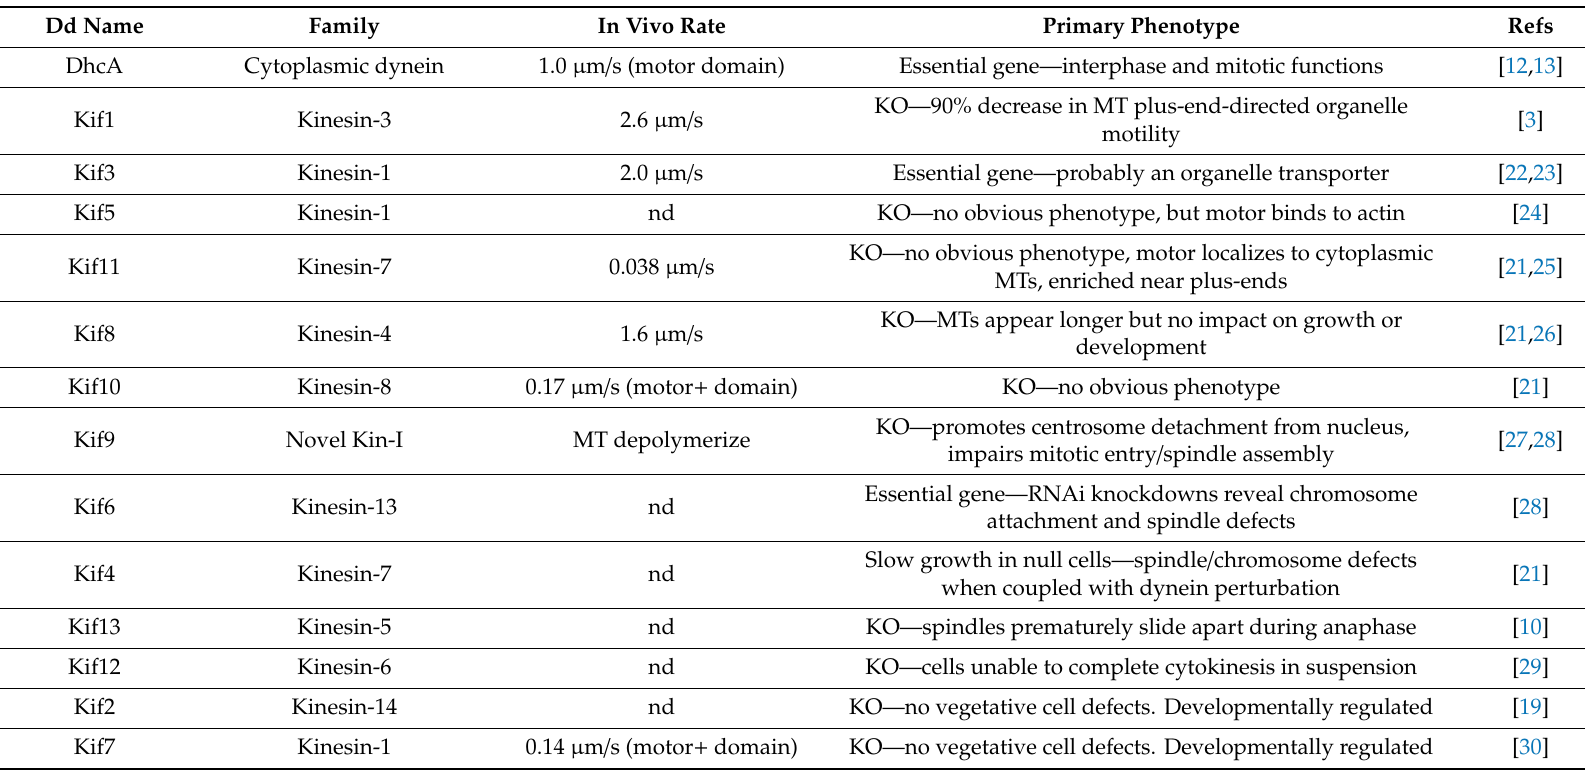
Table 1. A summary of the microtubule (MT)-based motor proteins in Dictyostelium discoideum . For detailed schematic representations of the kinesin motors organization, see references